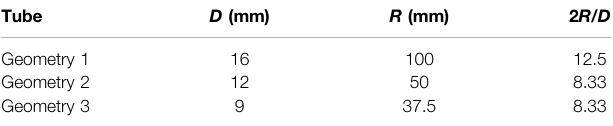
TABLE 2 | Geometric parameters of the tested U-bends.